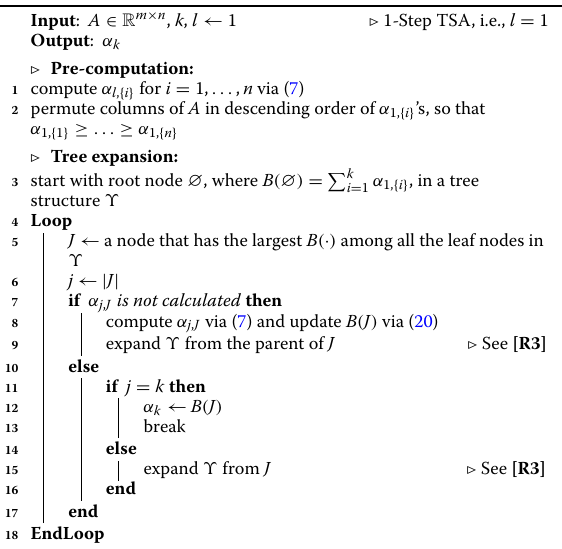
Algorithm 2: Tree search algorithm based on the pick-1-element algorithm (1-Step